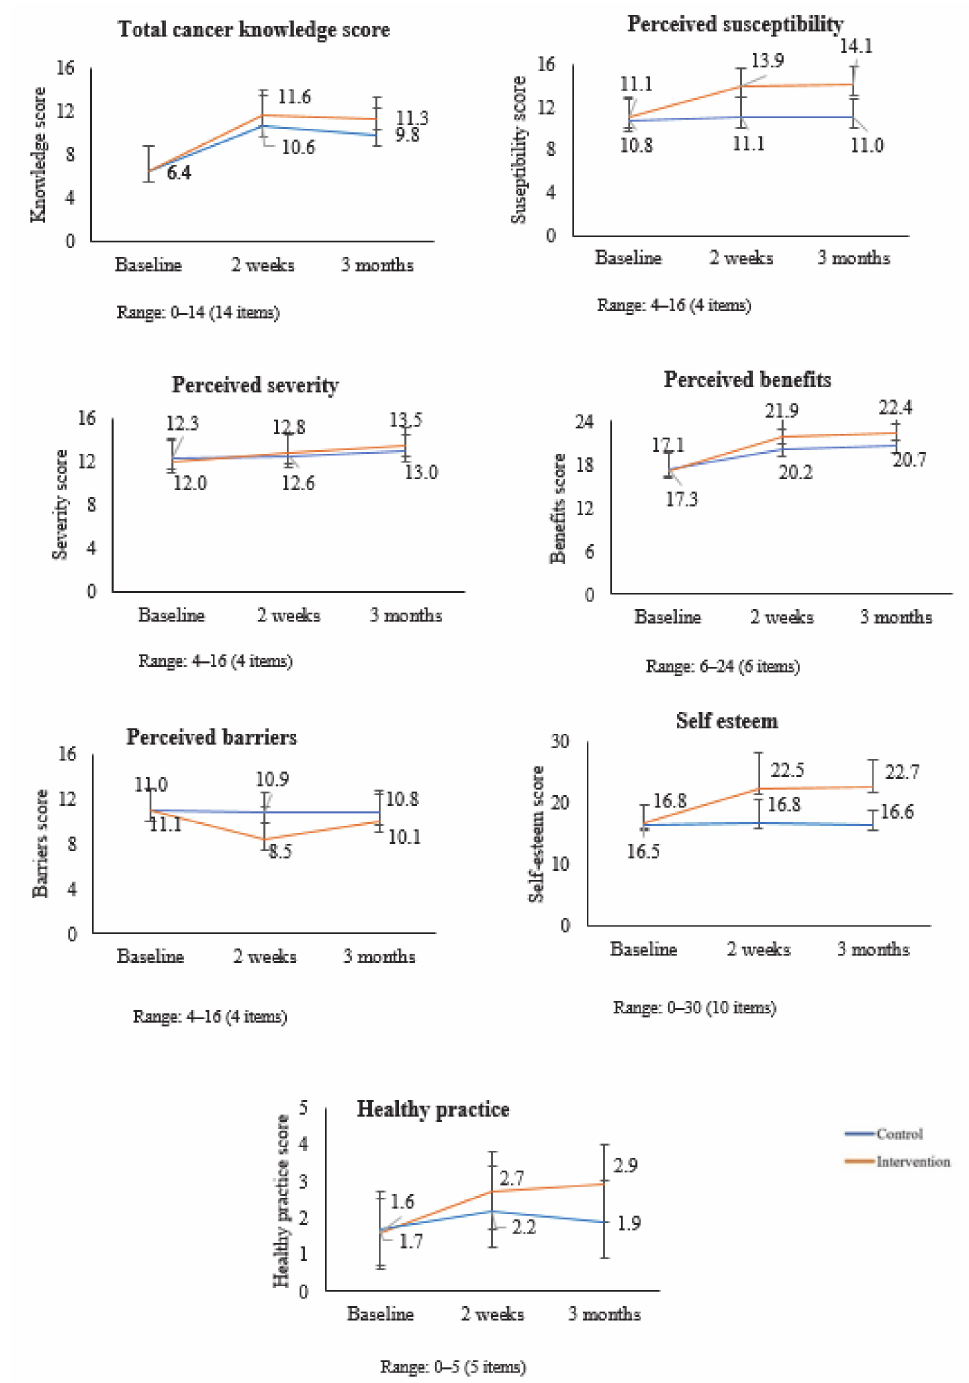
Figure 2. Changes in Knowledge, Total Health Belief Subscale Scores, Self- esteem, and Healthy Practice of Students over